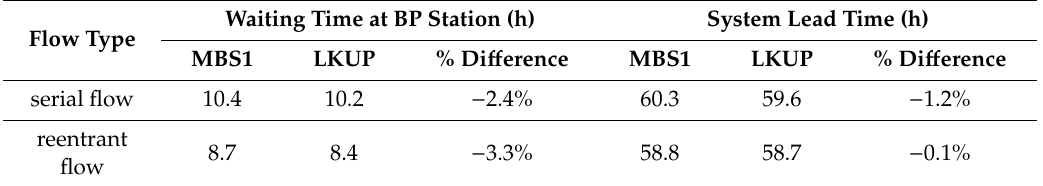
Table 3. Performance of LKUP (Look-Upstream) for the Serial and Reentrant Product Flows. Flow